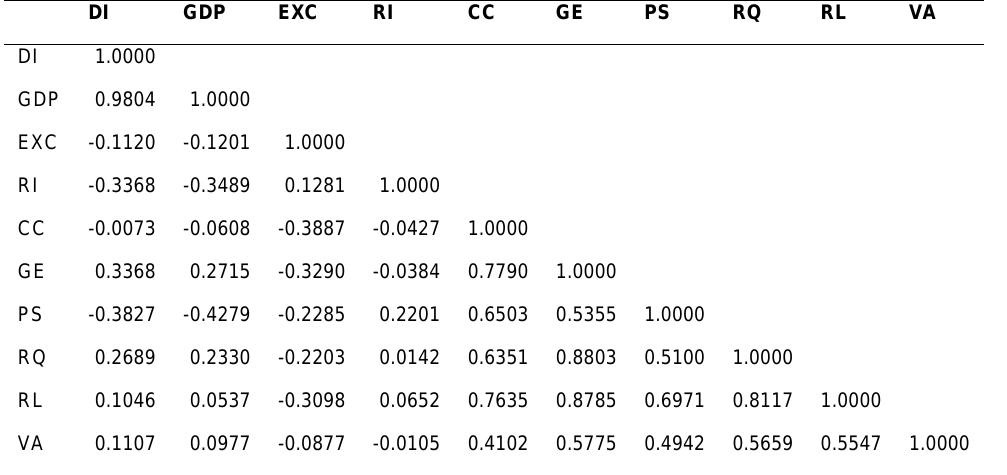
Table 3.2 . Correlation